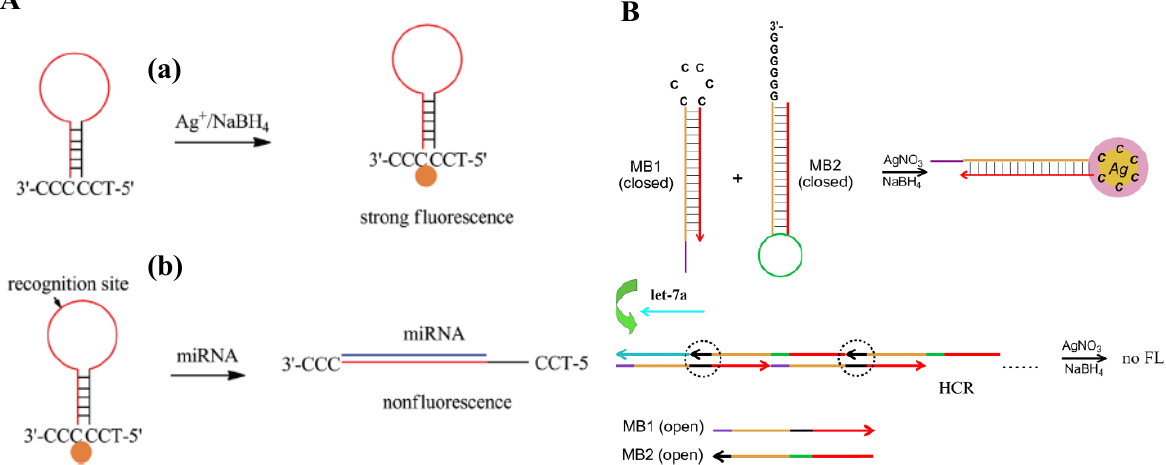
Figure 2. ( A ) Schematic representation of the creation of hairpin-shaped ODN probe/AgNCs for miRNA assay. (a) Template synthesis of AgNCs with strong fluorescence. (b) Hairpin-shaped ODN probe/AgNCs exhibited nonfluorescence or weak fluorescence after hybridization with target miRNA. Reprinted with permission from